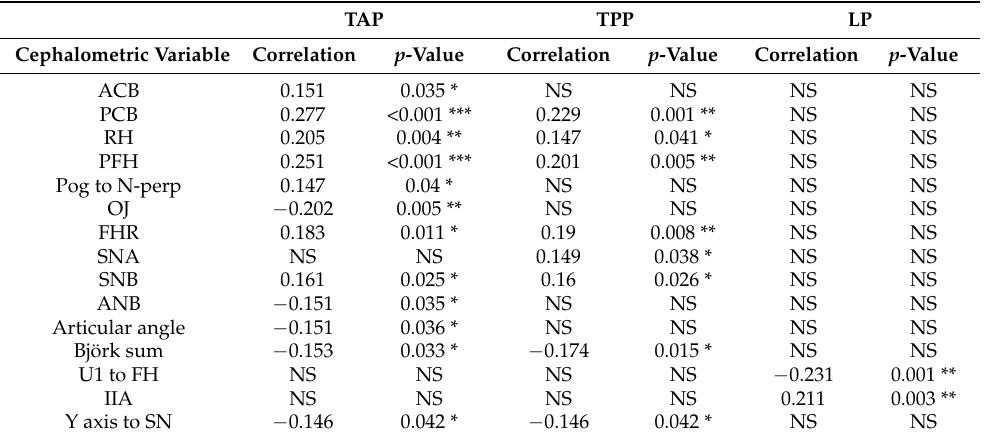
Table 2. Correlation coefficients between cephalometric variables and perioral muscle force (TAP, TPP, LP) †. TAP TPP